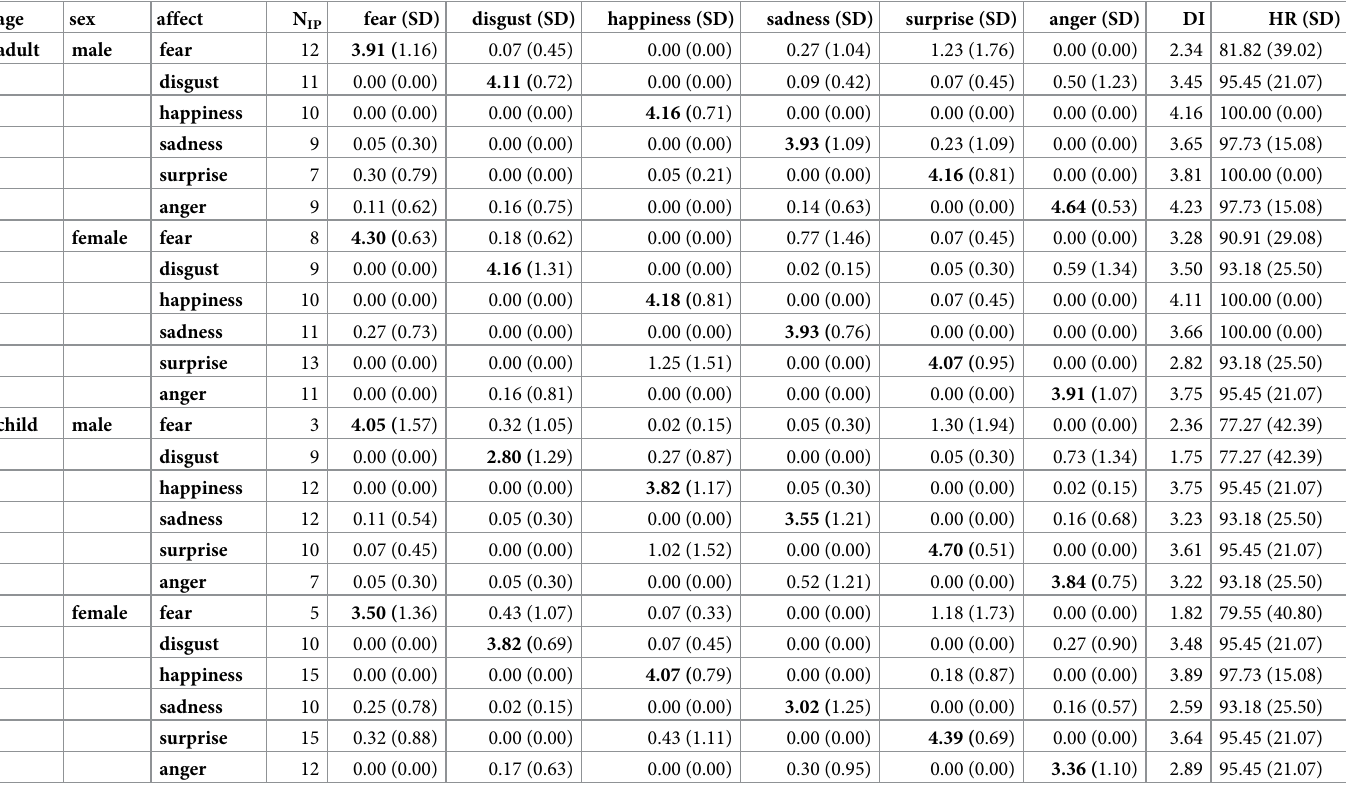
For closer examination, a two-factorial repeated-measures ANOVA with age (child vs. adult) and affect (fear, disgust, happiness, sadness, surprise and anger) as factors and intensity as dependent variable was computed. There was a main effect for age , F (1,43) = 33.91; p < .01; Table 2. Values of intensity, difficulty index (DI; range 0 to 5; difference between the highest affect rating and the added four other affect ratings) and hit rates (HR; in %) of the 24 assessed affect prototypical reference pictures.